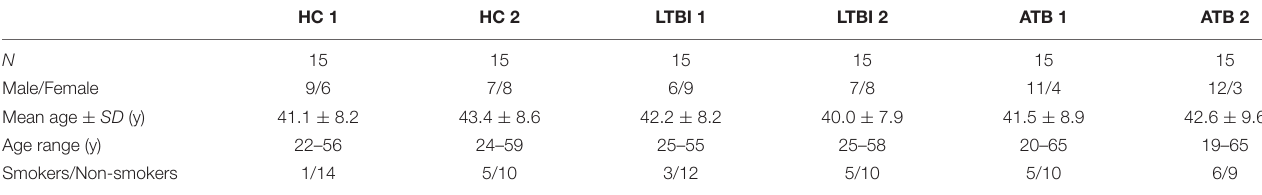
TABLE 1 | Clinical data of the